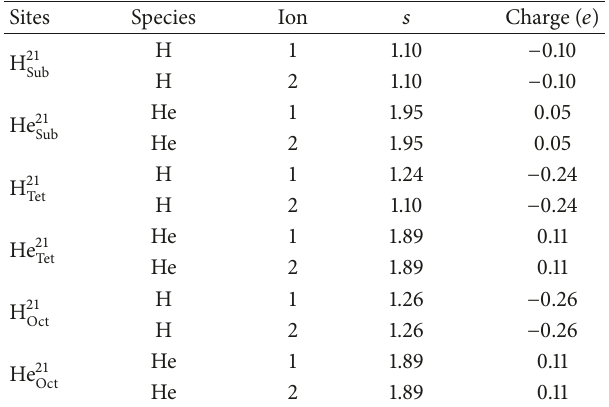
Table 3: Atomic populations (Mulliken) of H and He atoms in